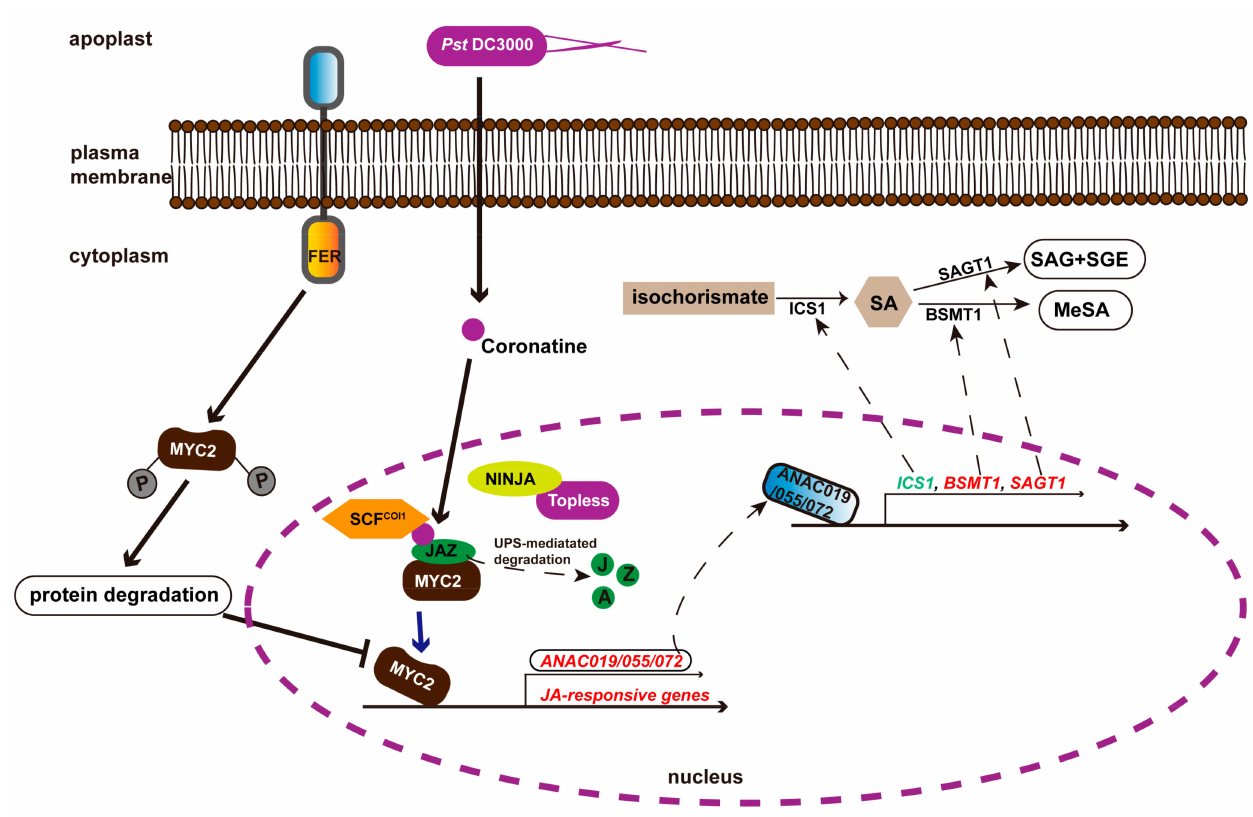
Figure 3. Schematic representation of the role of FER in regulating plant immunity through the JA and SA signaling pathways. Bacteria-secreted coronatine, which structurally and functionally mimics the active form of JA, utilizes MYC2 to activate the transcription factor NACs (ANAC019, ANAC055, ANAC072), which subsequently regulate the expression of genes involved in SA biosynthesis and metabolism to repress SA accumulation, and, thus, compromise plant immunity. FER regulates immunity by interacting with, phosphorylating, and destabilizing MYC2 to relieve the inhibitory effects of coronatine and JA on SA accumulation mediated by the MYC2–NACs module [73,101]. Red (BSMT1 and SAGT1) indicates activation, and green (ICS1) indicates suppression of transcription factor-regulated gene